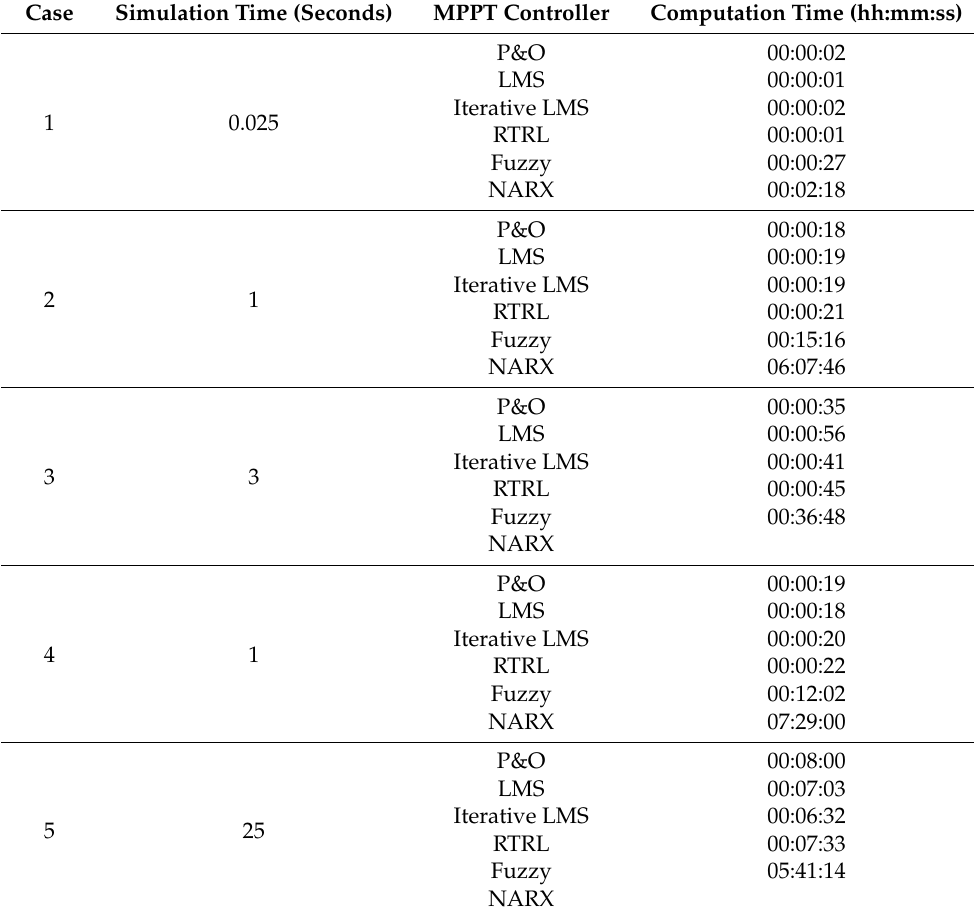
Table 4. Simulation and computation times obtained for the